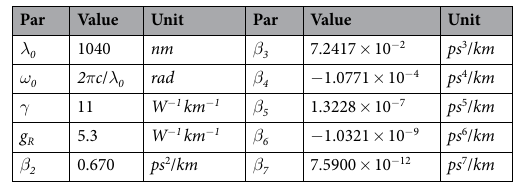
Table 1. Parameters of PCF